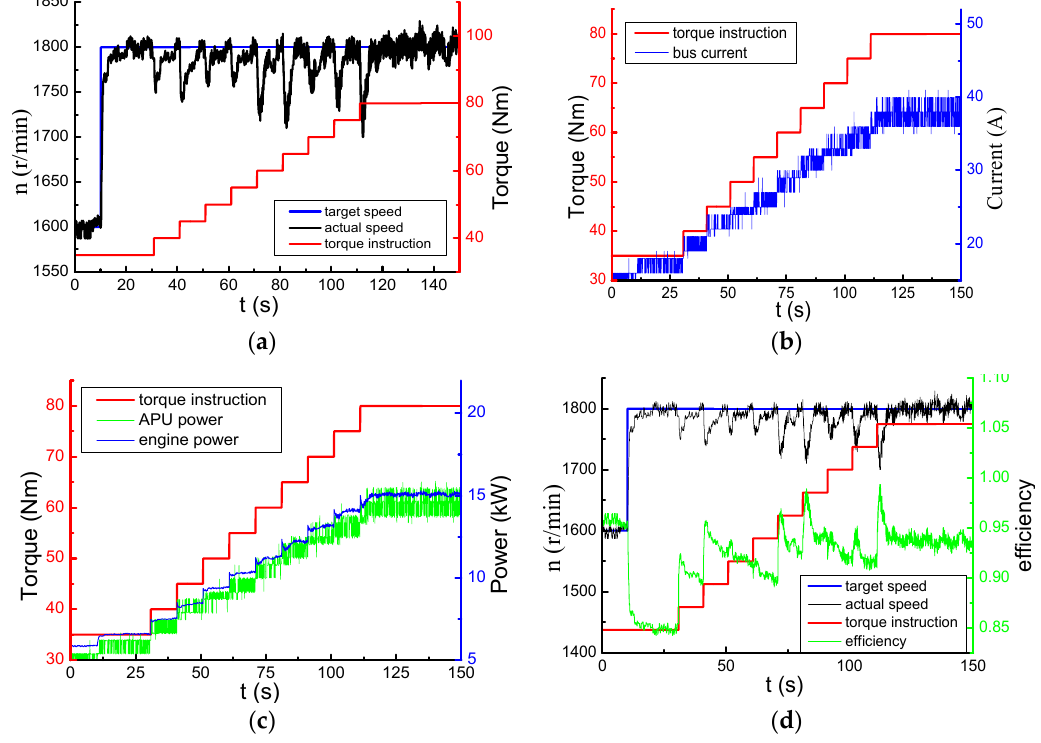
Figure 18. Control process from warm-up to operating point. ( a ) Speed control; ( b ) Charging current; ( c ) Power change; ( d ) Efficiency of the generator.